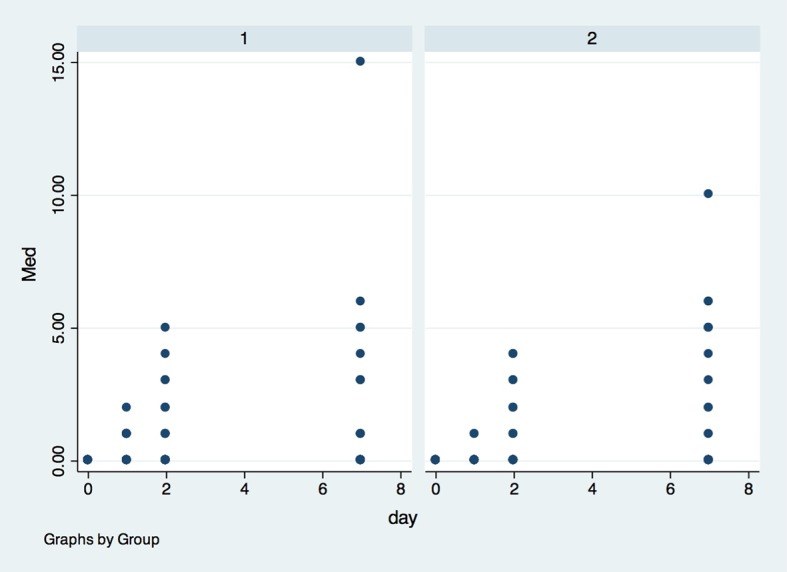
Intake of pain medication in both groups in the four observed timepoints.X axis–medicines ingested in absolute numbers, Y axis–measures were performed in baseline (0), 1, 2 and 7 days after surgery; (1)- placebo group, (2)- laser group.